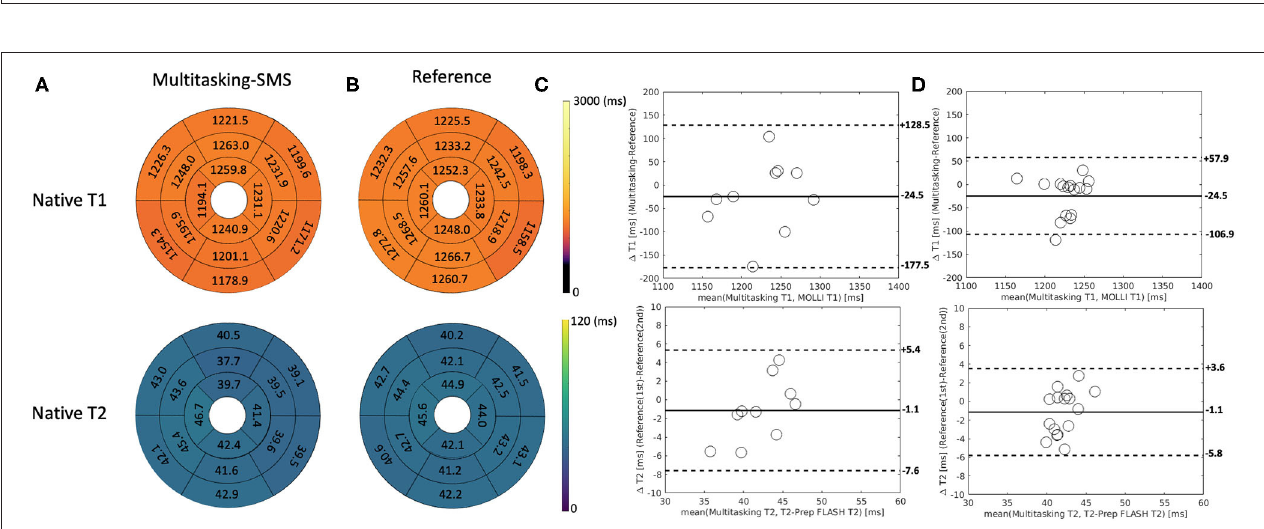
FIGURE 7 | (A,B) The 16-segment AHA model for the proposed Multitasking-SMS T1/T2 maps and the reference T1/T2 maps in the myocardium in all 10 healthy subjects. (C) The Bland-Altman plot compares the subject-wise global myocardium T1/T2 differences in 10 healthy subjects. (D) The Bland-Altman plot compares the segment-wise T1/T2 differences in 10 healthy subjects. The dash lines represent 95% limits of agreement, and the solid lines represent mean bias.